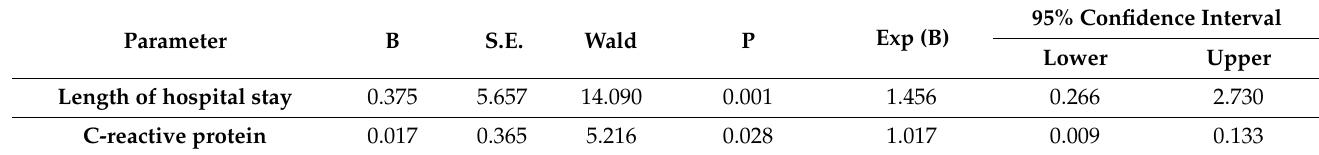
Table 8. Multivariable logistic regression analysis of mortality risk factors.